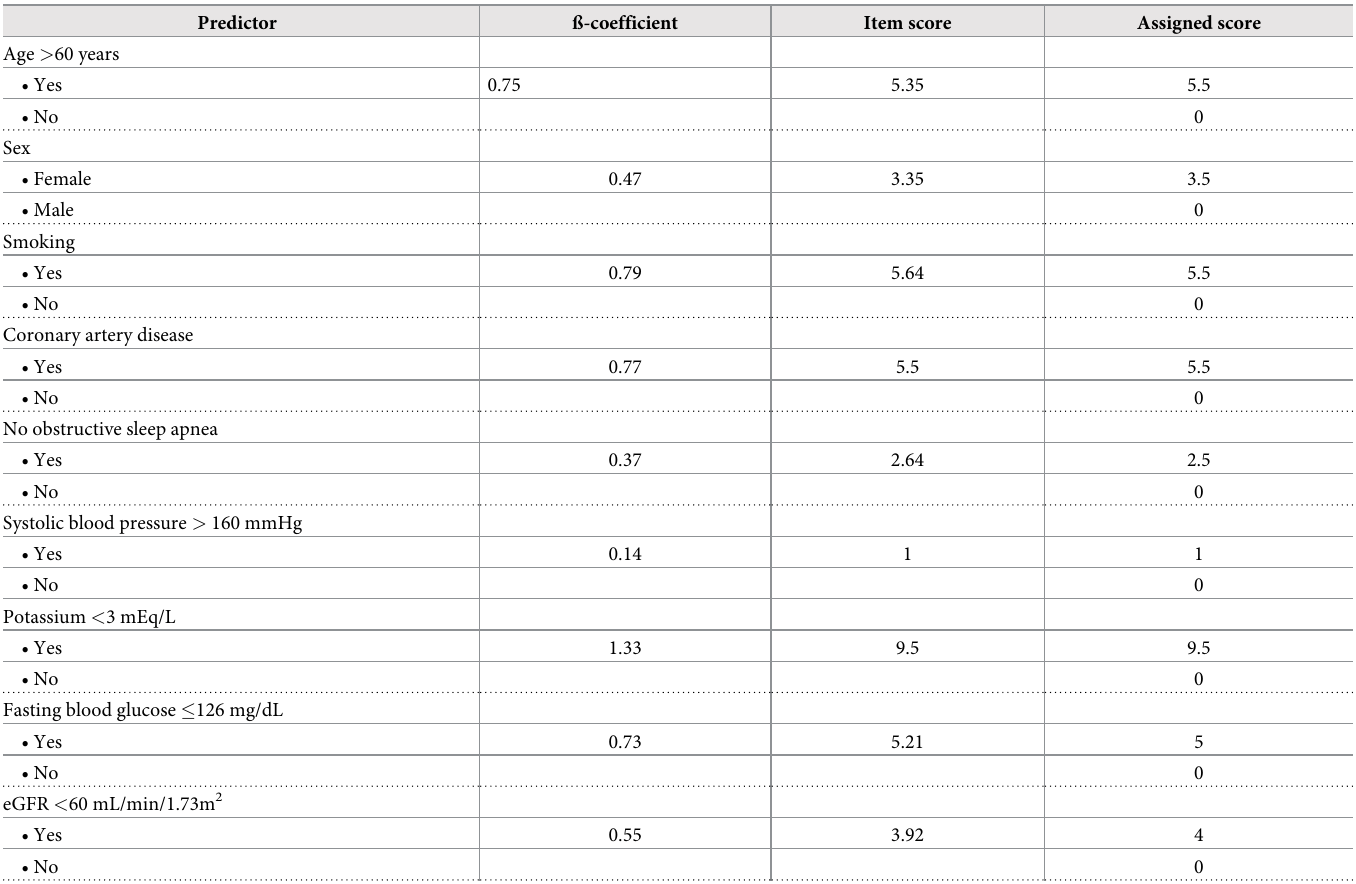
Table 3. Predictive score for the diagnosis of primary aldosteronism.